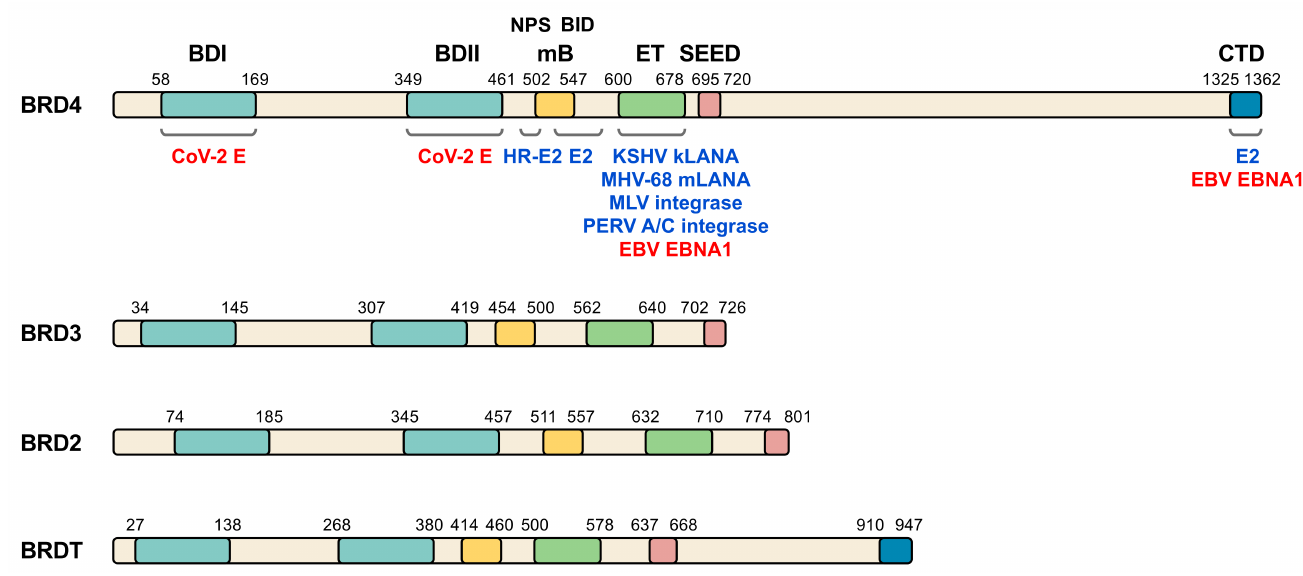
Figure 1. BET family of proteins and viral interacting proteins. The four members of human BET family are represented and amino acid position of the main relevant domains is indicated (BDI, bromodomain I; BDII, bromodomain II; mB, motif B; ET, extra terminal domain; SEED, SEED domain; CTD, C-terminal domain; NPS, N-terminal phosphorylation sites region; BID, basic residue-enriched interaction domain). Different virus proteins demonstrated to directly interact with BET domains (blue) or postulated to interact (red) are shown on BRD4, although some of the indicated proteins also interact with other BET members. CoV-2 E, SARS-CoV-2 E protein. See Table 1 and text for details and